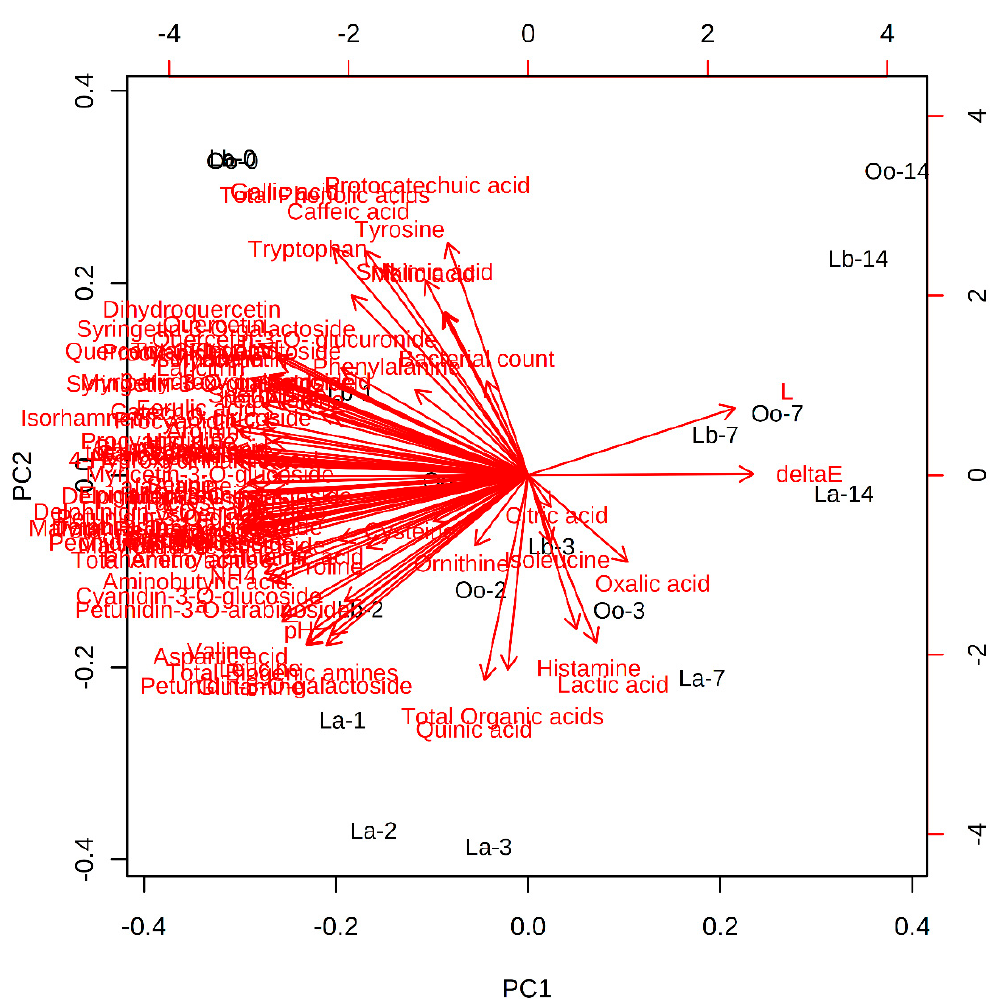
Figure 4. Principal component analysis of all compounds ( n = 85) in the bog bilberry juices in fermented for 0–14 days using lactic acid bacteria strains (Lb Lactobacillus brevis , Oo Oenococcus oeni , La Lactobacillus acidophilus